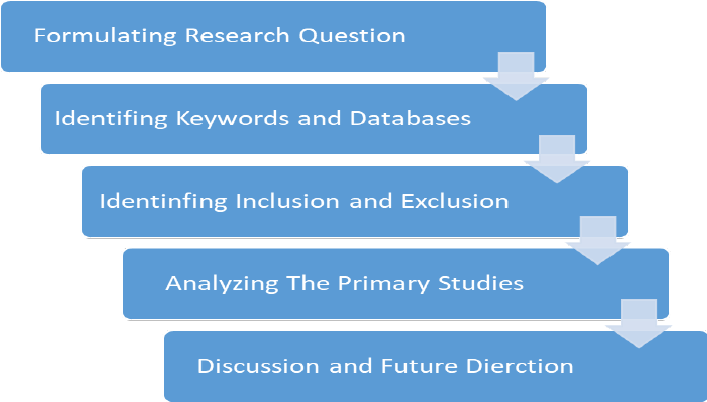
Figure 1. Methodology utilized in this study.